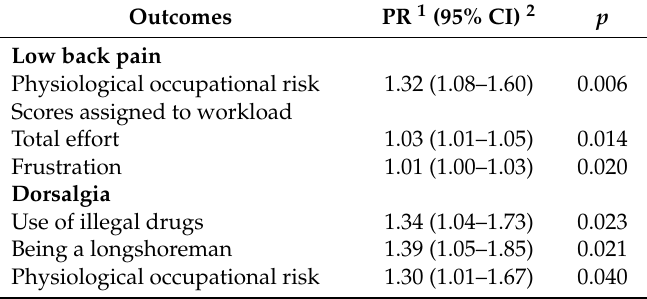
Table 6. Poisson regression analysis to avoid factors independently associated with dorsalgia or low back pain.